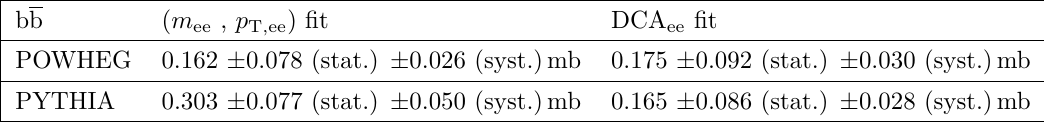
Table 5 . Summary of the total bb cross sections extracted from a (cid:12)t of the measured dielec- tron spectra from heavy-(cid:13)avour hadron decays in ( m ee , p T ; ee ) and in DCA ee with PYTHIA and POWHEG. The uncertainty of 6% [89] on the branching fractions and fragmentation functions (BR ) is not b( ! c) ! e